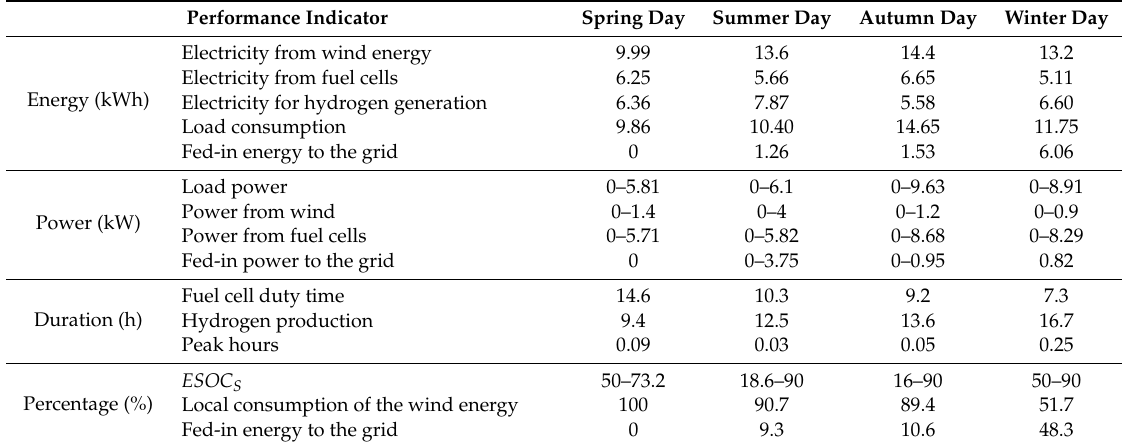
Table 2. Key performance indicators of the proposed system.